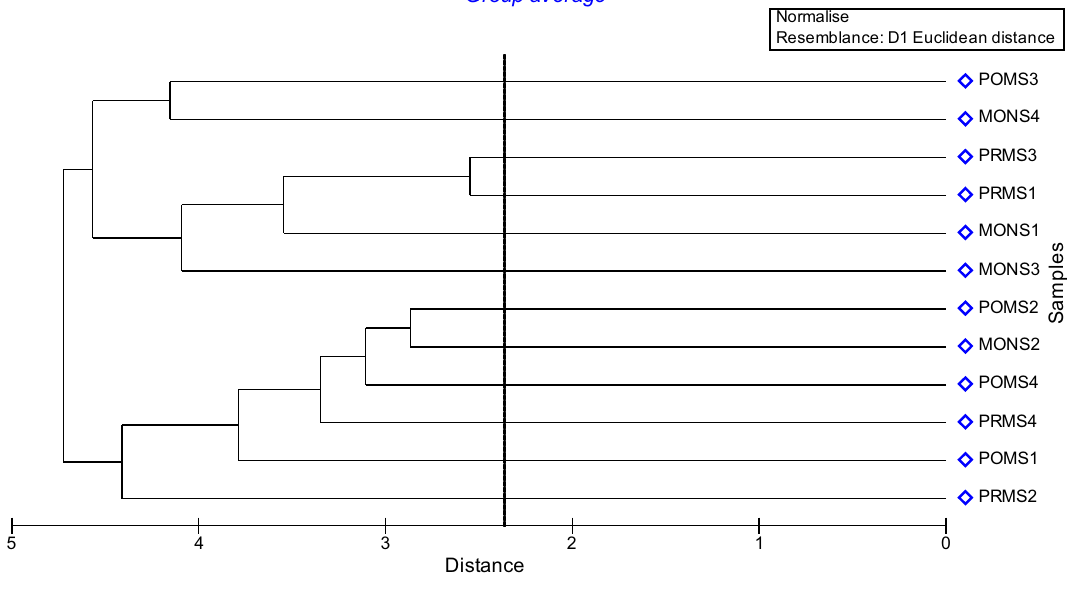
Normalise Resemblance: D1 Euclidean distance